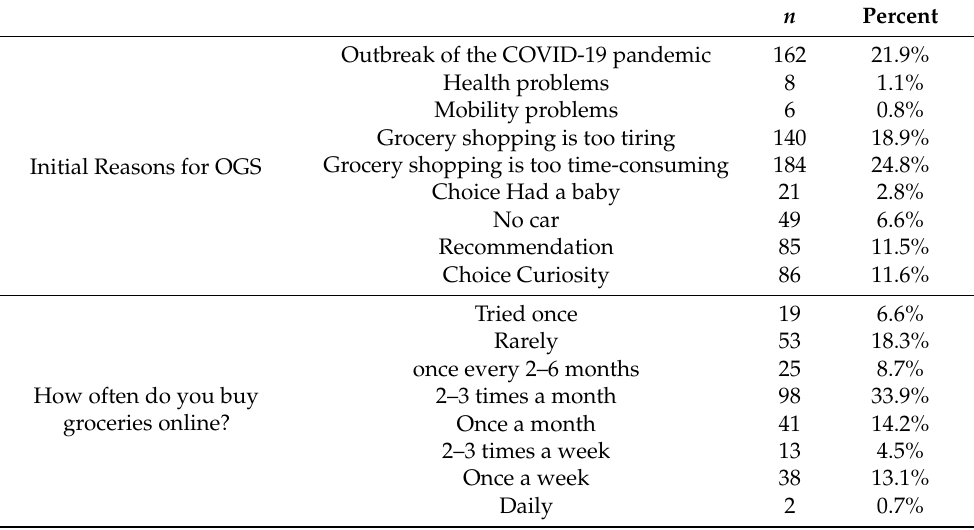
Table 2. Distribution Sample